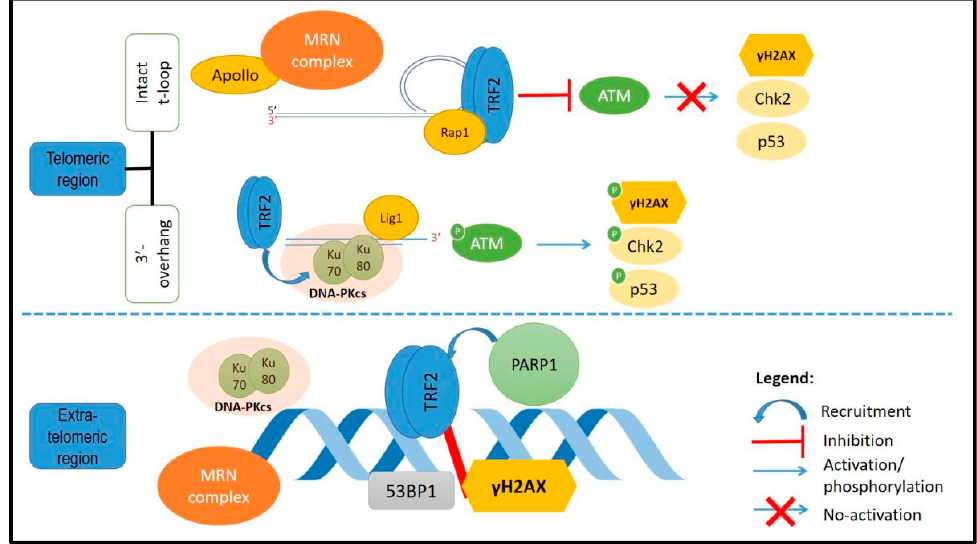
Figure 2. DNA damage response factors involved with TRF2 at the telomeres or outside of the telomeres. At the telomeres, TRF2 will maintain the t-loop structure and inhibit the ATM kinase pathway activation. Outside of the telomeres, TRF2 was reported to be recruited at the DNA damage site and colocalized with other DDR factors.